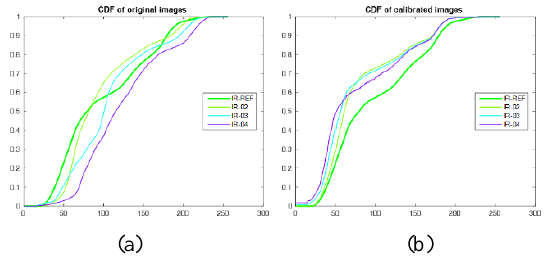
Figure 7: (a) CDFs of original thermal images and (b) CDFs of calibrated